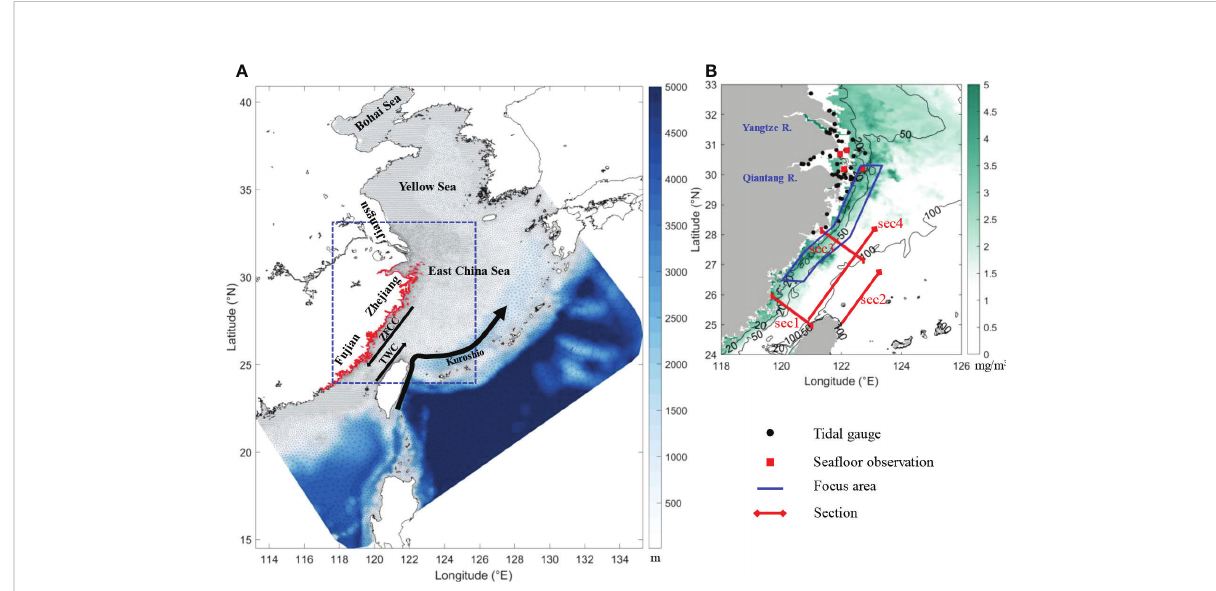
FIGURE 1 (A) Bathymetry and mesh grid of the studied region, the Zhejiang-Fujian coast is highlighted in the red line. (B) Monthly MODIS-Aqua chlorophyll-a concentration off the Zhejiang-Fujian coast in March,